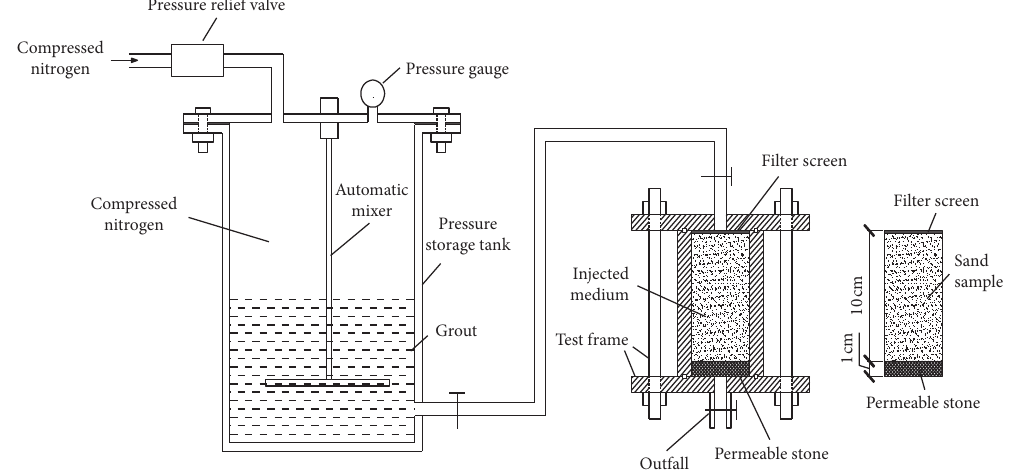
Figure 1: The test apparatus used in the sand penetration grouting simulation test. Table 1: The chemical composition of the cement used in the tests. Cement